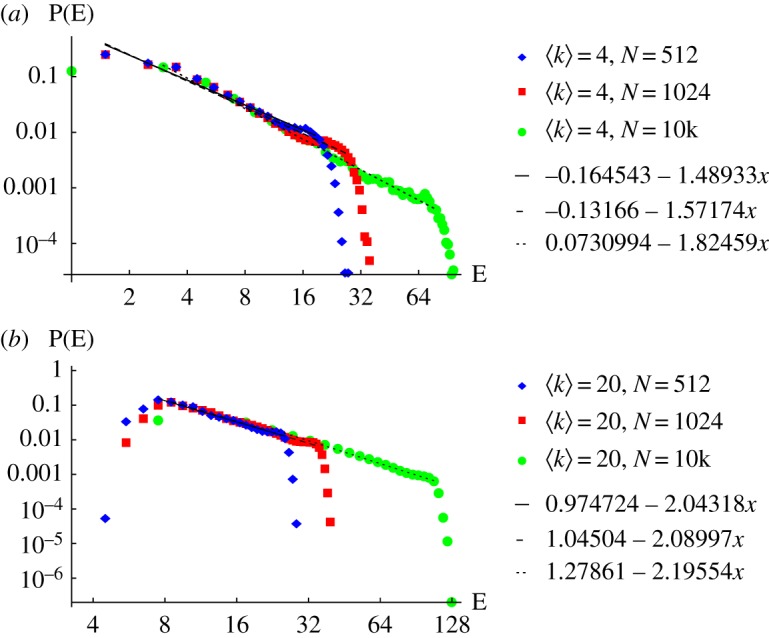
Fitting the heavy tail of the distribution of the nearest-neighbour GENs for the Barabási–Albert networks in figure 8a,b on log–log axes. Over a wide range of values, there is an approximate power-law decay which is very weakly dependent on N (N = 512 in the blue diamonds, N = 1024 in the red squares, and N = 104 in the green circles) but does depend on the average connectivity (〈k〉 = 4 in (a) and 〈k〉 = 20 in (b)). This is consistent with the weak N dependence seen for the ER networks in equations (A 4) and (A 5).